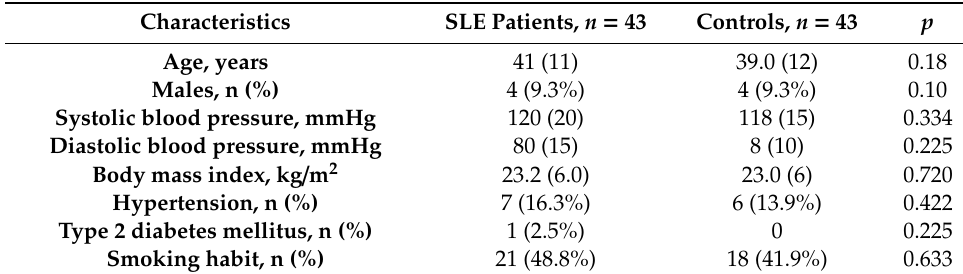
Table 1. Characteristics of SLE (systemic lupus erythematosus) and controls subjects.